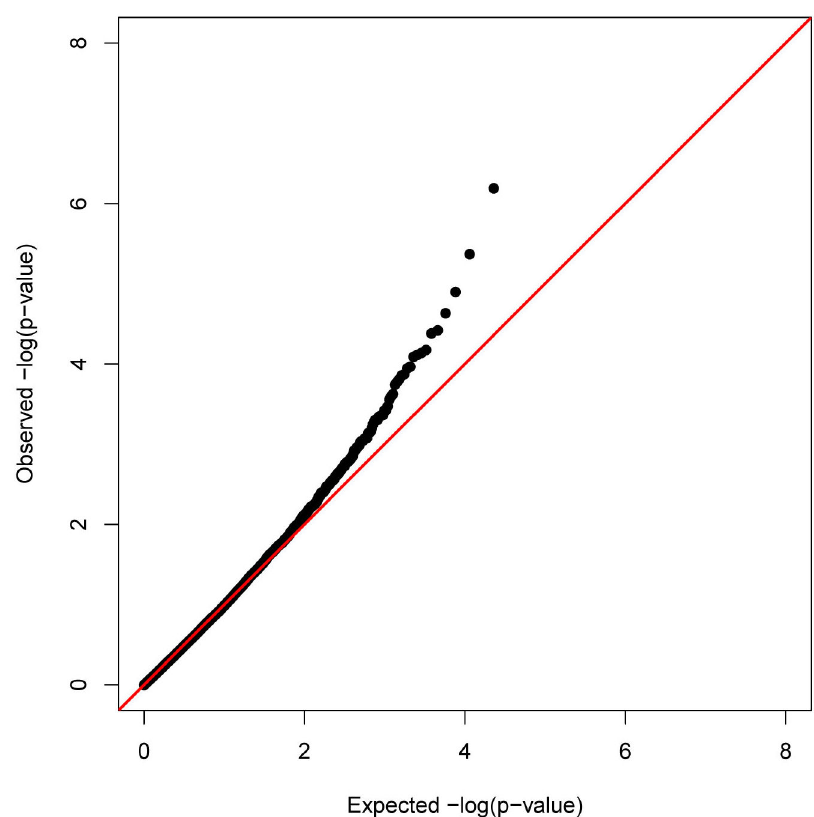
Figure 3. Quantile-quantile plot of DNAm association with lnCRP adjusted for top three principal components of the DNAm